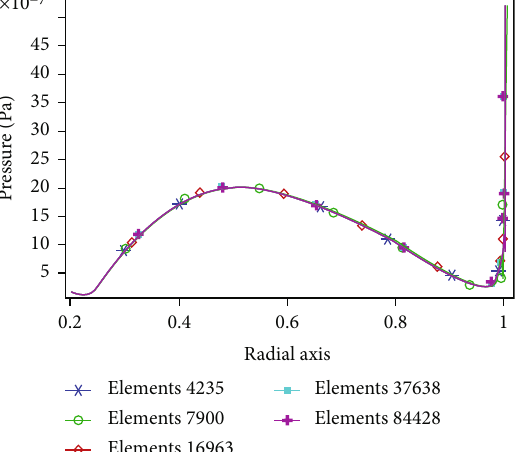
Figure 2: Di ff erent con fi gurations of the mesh setting from normal to extremely fi ne mesh.